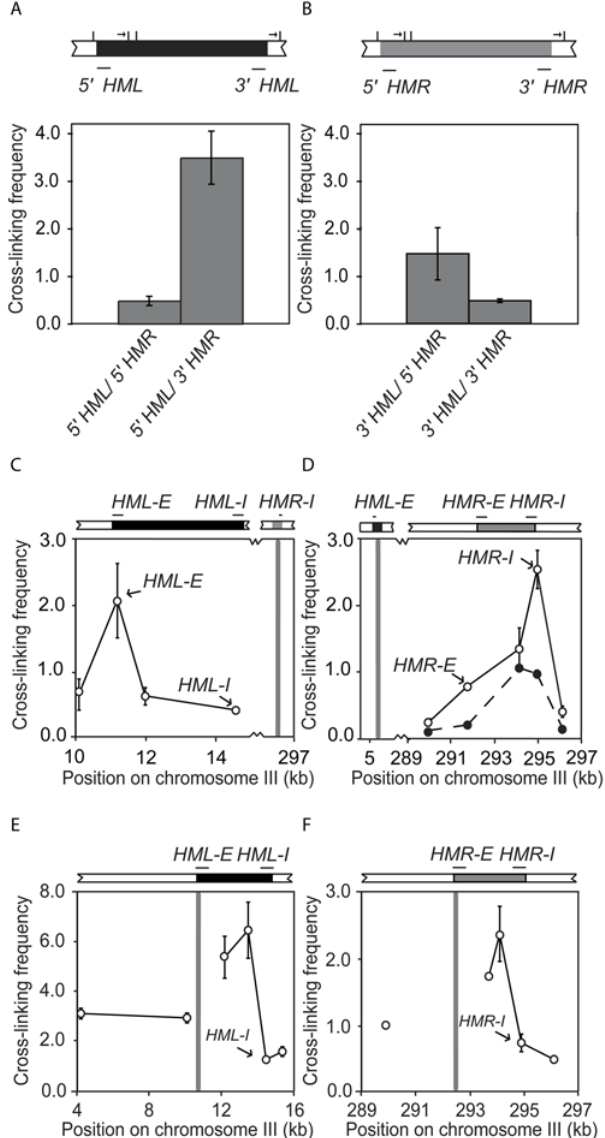
Figure 2. Preferred interaction of E - and I - silencers from opposite silent loci. Hatch marks represent restriction sites. (A) Crosslinking frequencies between the Xba I fragment containing 5 9 end of HML and either the 5 9 end of HMR or the 3 9 end of HMR in MAT a cells. (B) Crosslinking frequencies between the Xba I fragment containing 3 9 end of HML and either the 5 9 end of HMR or the 3 9 end of HMR . (C) Analysis of interactions in MAT a cells between the Aci I fragment containing HMR-I (position 294510–295324, primer O52; primer sequences are given in Table S1) with fragments within and immediately outside of HML . (D) Analysis of interactions between the Aci I fragment containing HML-E (position 10815–11636, primer O42) with fragments within and immediately outside of HMR (open circles). Analysis of interactions between an Aci I fragment within HML (position 11679–11906, primer O43) with fragments within and immediately outside of HMR (black circles). (E) Analysis of interactions in MAT a cells between the Aci I fragment containing HML-E with sites within and immediately outside of HML . (F) Analysis of interactions in MAT a cells between the Aci I fragment containing HMR-E with sites within and immediately outside of HMR .